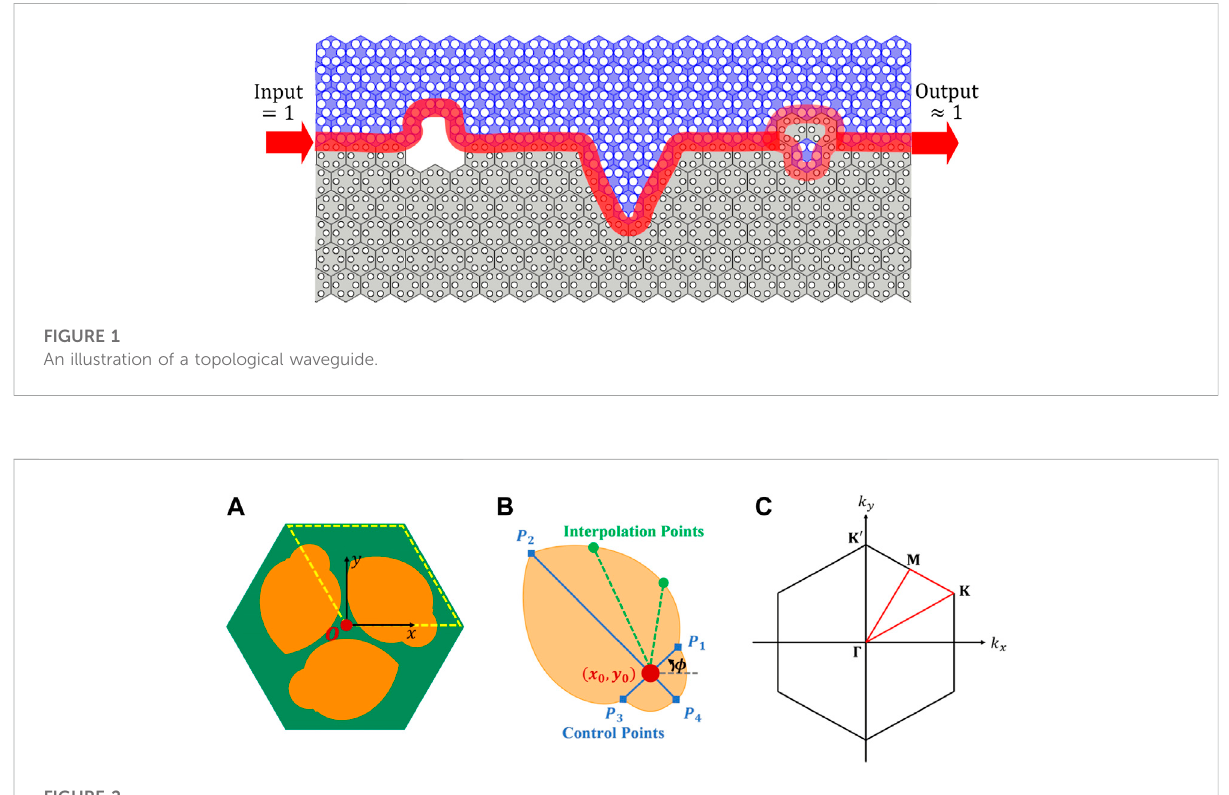
FIGURE 2 (A) The C 3 -symmetric hexagonal UC described by the MMCs, (B) the design variables of each MMC and (C) the fi rst irreducible Brillouin zone boundary of the hexagonal UC.